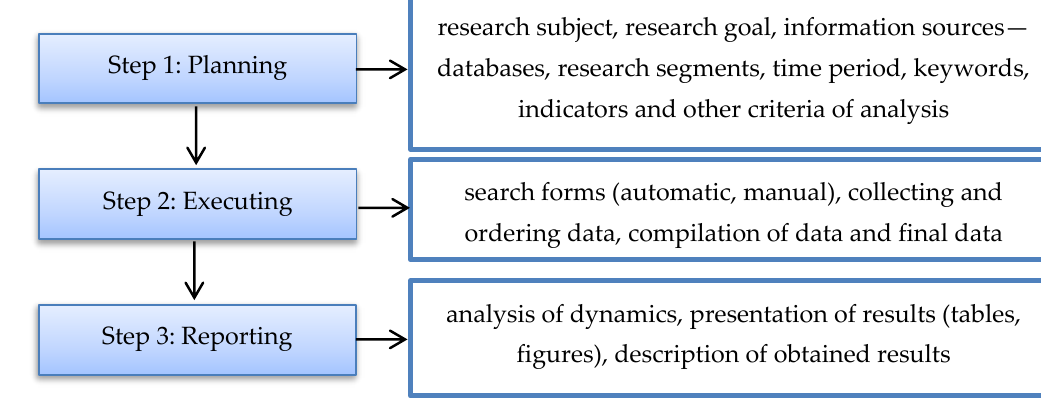
Figure 1. Bibliometric process based on SLR. Source: Own study.